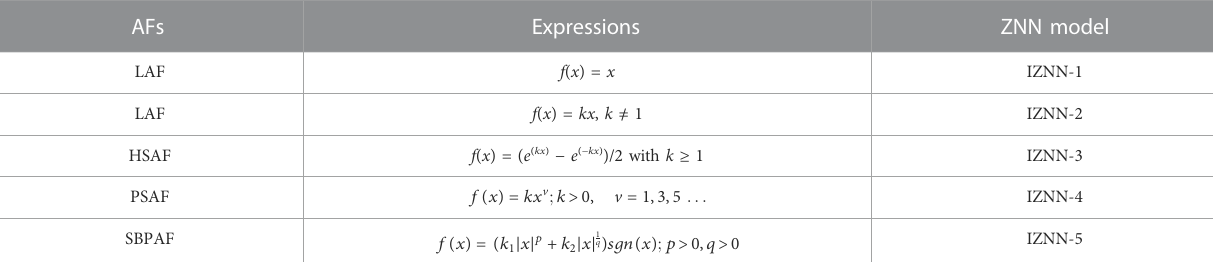
TABLE 1 Classical activation function and ZNN